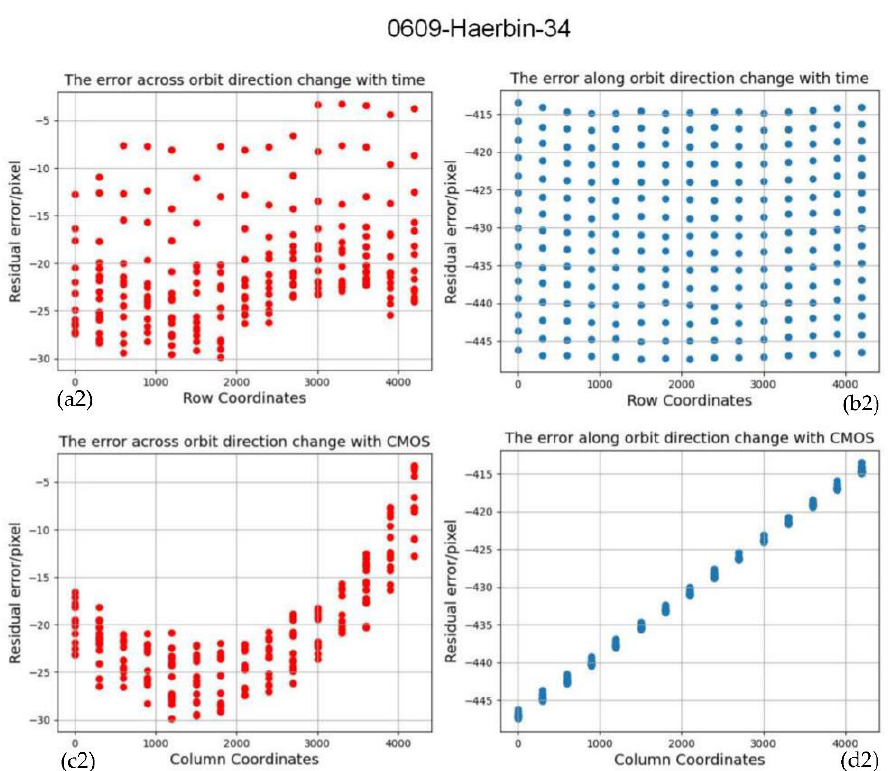
Figure 1. The error changes with time and CMOS of different images: ( a1 , a2 ) the error across orbit direction changes with time, ( b1 , b2 ) the error along orbit direction changes with time, ( c1 , c2 ) the error across orbit direction changes with CMOS, ( d1 , d2 ) the error along orbit direction changes with CMOS. (Red in-dicates across orbit direction, blue indicates along orbit